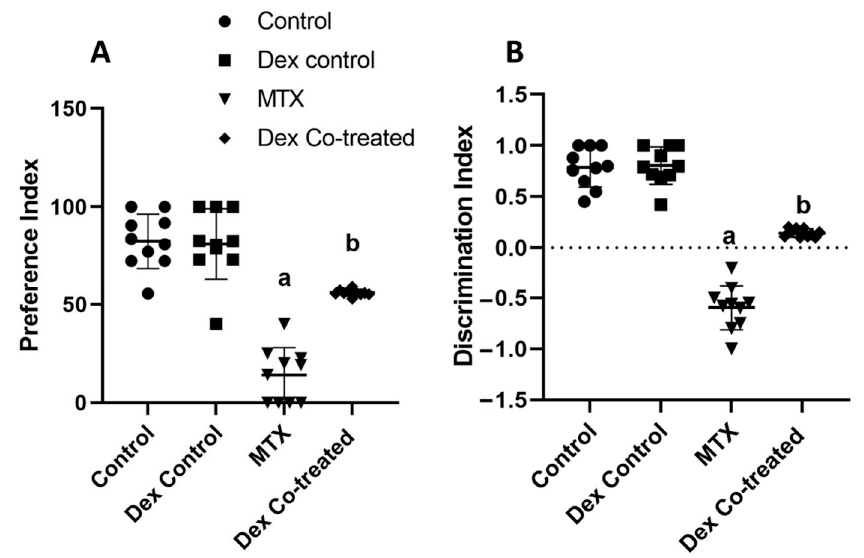
Figure 1. Cognitive and behavioral effects of MTX and Dex co-treatment (novel object recognition test). ( A ) Preference index for the novel object recognition test indicates a lower preference for the novel object in the MTX group compared to other groups. ( B ) Discrimination index for the novel object recognition test indicates negative discrimination between the novel and familiar objects in the MTX group compared to other groups. Data are expressed as mean ± SD, n = 10. (a) Significant difference from control, and (b) significant difference from MTX. Significance level is set at p < 0.05. One-way ANOVA followed by Tukey’s post hoc test were used in the statistical